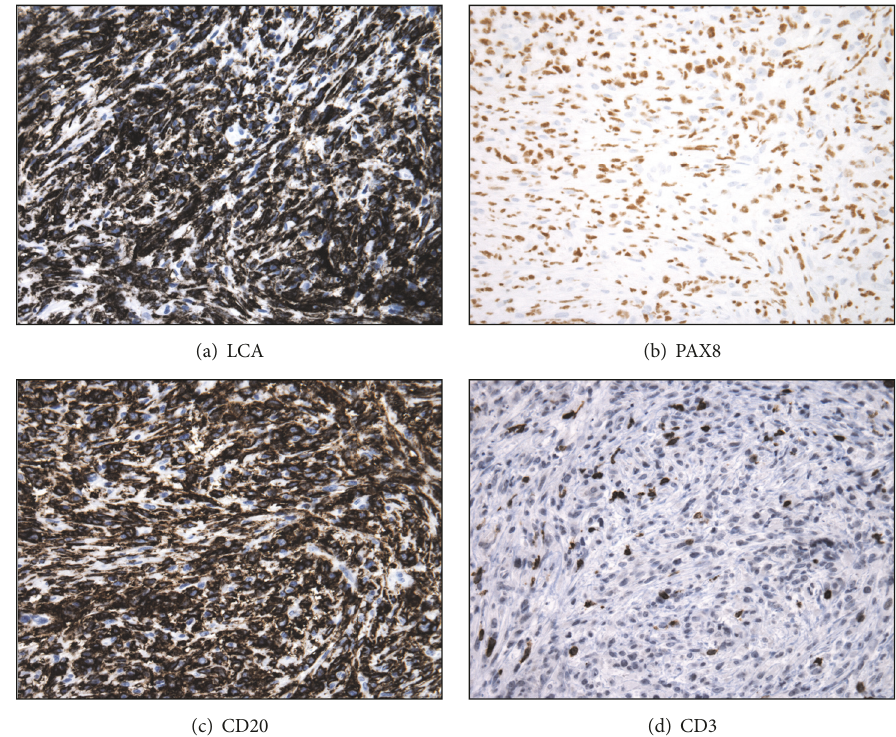
Figure 3: Reevaluation of the original dura/calvarium lesion is consistent with diffuse large B-cell lymphoma. (a-b) Immunostains for LCA and PAX8 were diffusely and strongly immunoreactive in the tumor, supporting the diagnosis of lymphoma. The presence of CD20 and the absence of CD3 in neoplastic cells were consistent with a lymphoma of B-cell lineage (CD3 is present in nonneoplastic T-cell